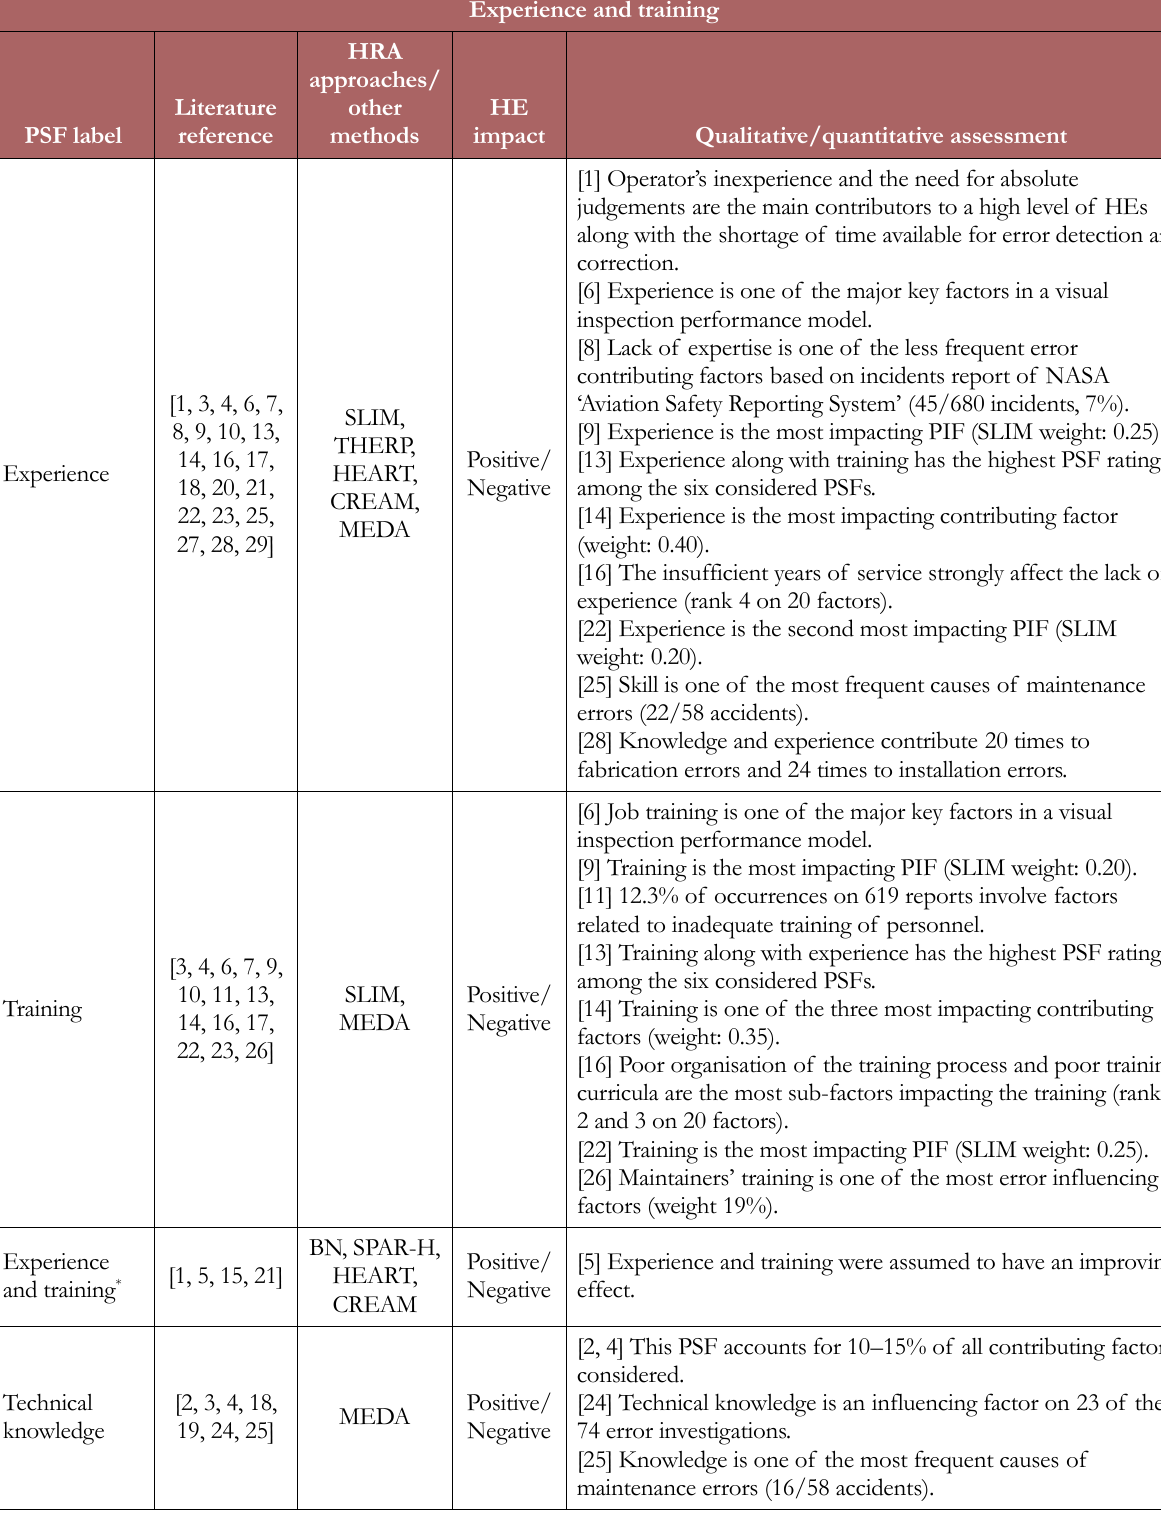
Table 3. Taxonomy of maintenance PSFs: experience and training